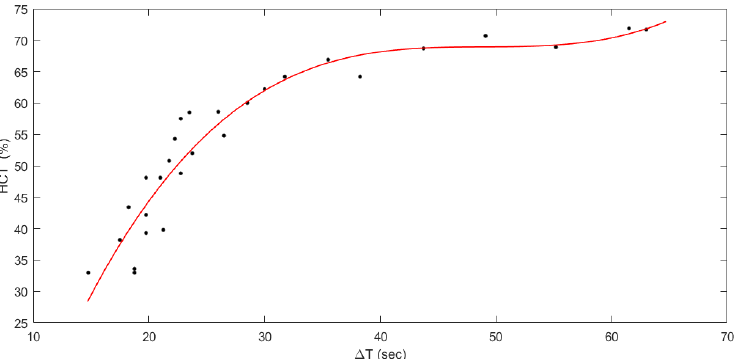
Figure 4. The measured HCT was plotted against Δ t (black dots—calibration data) and fitted with a third-degree polynomial equation (red line).